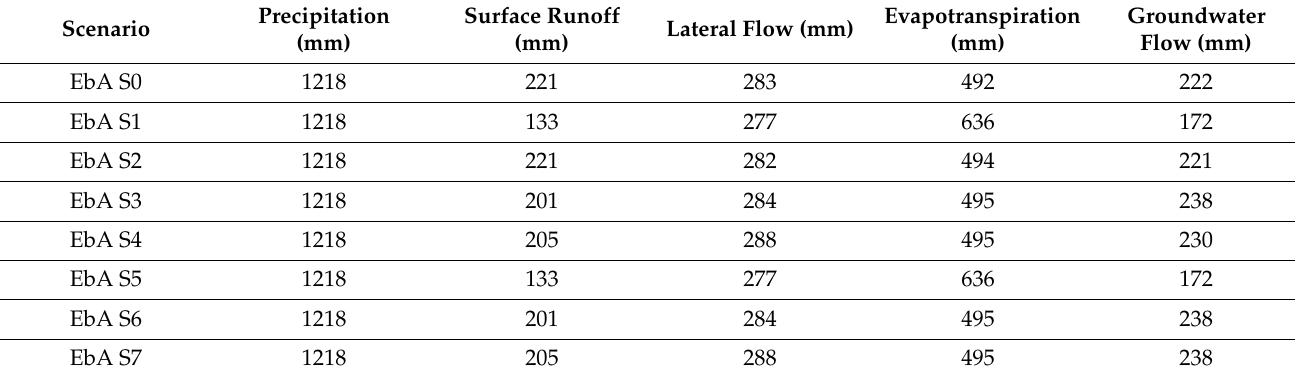
Figure 8. Soil erosion severity in the Huai Ta Poe under different EbA scenarios. Table 9. Average annual water balance components under different EbA